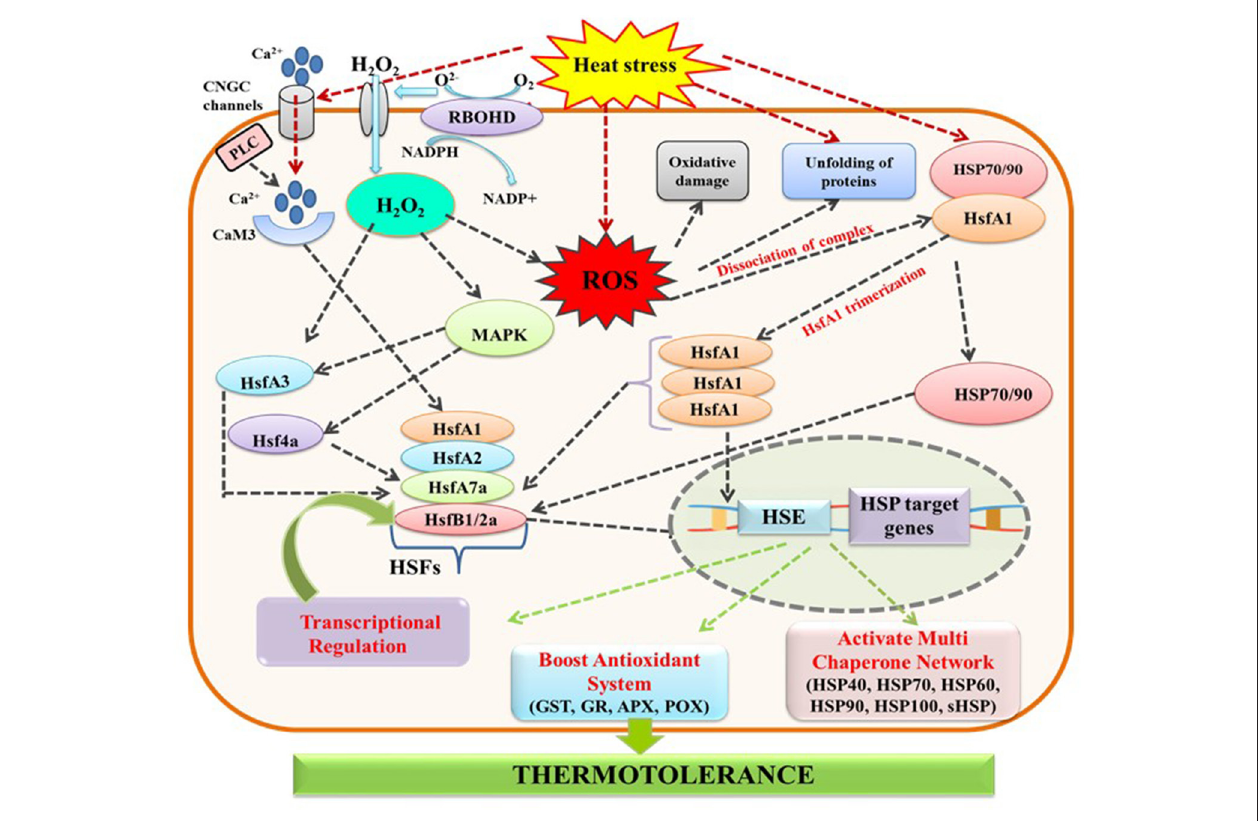
FIGURE 4 | Cross talk between HSPs and redox reaction: - Heat stress imposes damages to plant like increased membrane fluidity, unfolding of proteins, ROS production and dissociation of HSP70/90-HsfA1 complex. To endure HS, Plants activate various mechanisms to preserve their adaptation. First such mechanism is the activation of cyclic nucleotide gated calcium (CNGC) channels that result in the movement of Ca 2 + ions in to cytoplasm and bind with Calmodulin Protein (CaM3) forming the Ca 2 + -CaM3 complex and help in the activation of Heat shock factors (HSFs). Second mechanism involves Phosphoinositol signaling pathway that also lead to the influx of more Ca 2 + in to the cytoplasm and merge with Ca 2 + -CaM3 pathway. Another mechanism during HS is the activation of ROS signaling network by Respiratory Burst Oxidase Homolog D (RBOHD) that produce O 2 − which is converted in to H 2 O 2 that is involved in the induction of HSFs activation. ROS like H 2 O 2 also activate the HSFs complex through mitogen activated protein kinase (MAPK). On activation, HSFs move to the nucleus and activate HSE and HSP target genes. HS also lead to the dissociation, of HSP70/90-HsfA1 complex; on dissociation HsfA1 undergoes trimerization that further activates the HSFs complex in the cytosol and Heat shock element (HSE) in the nucleus. Their activation has many positive effects on the cellular metabolism like transcriptional regulation, activation of antioxidant system and multi chaperone network (HSP60, HSP70, HSP90, HSP100, and sHSP) that may lower down the ROS levels in the cell and help in achieving